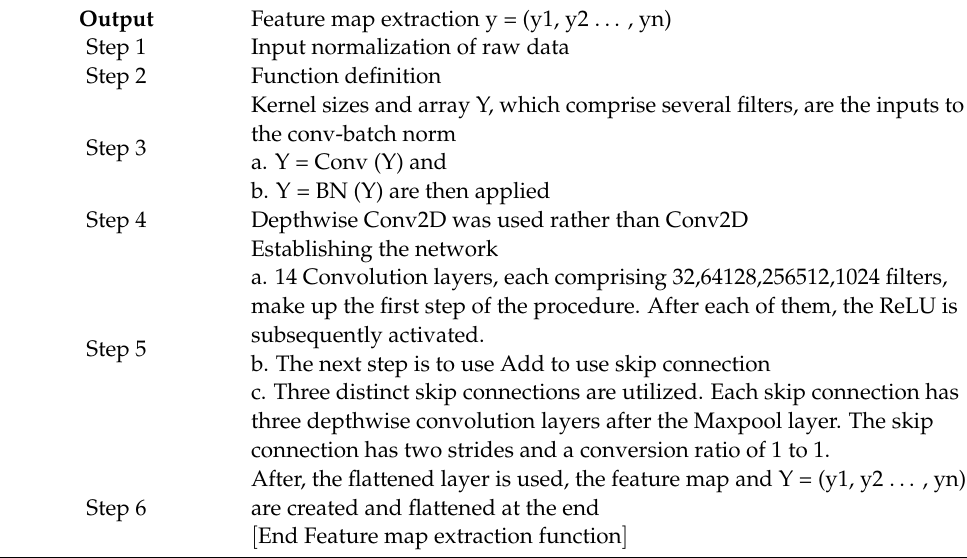
Algorithm 1: Implementation of the proposed Mobile-HR model for feature map extraction